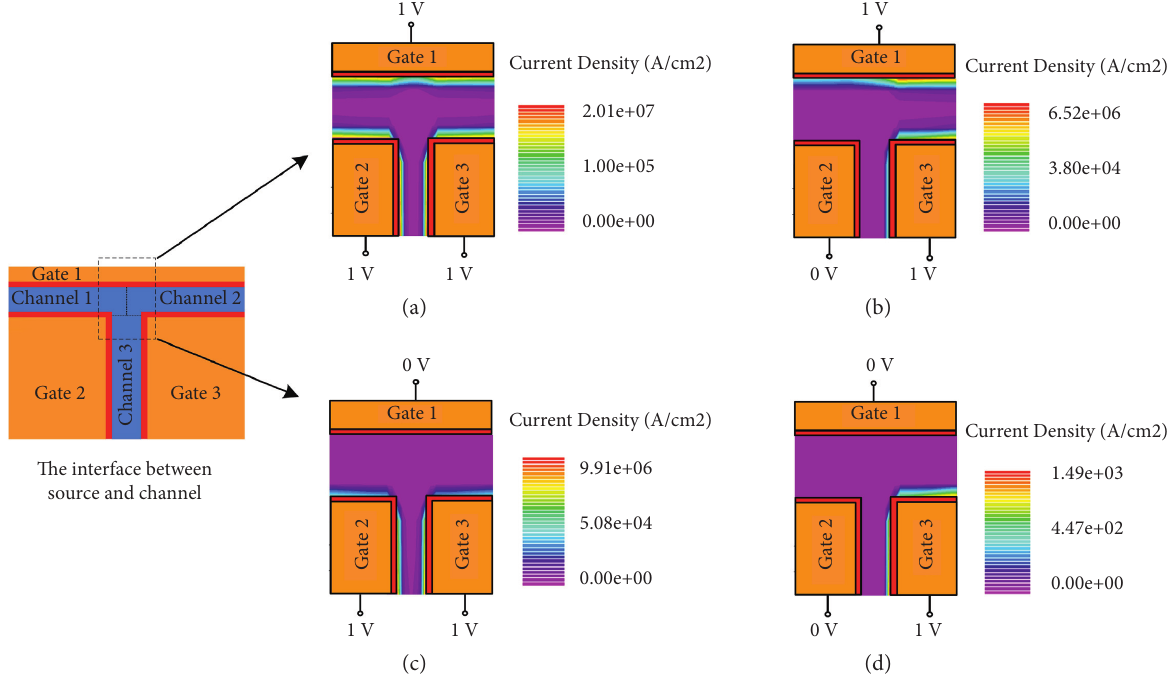
Figure 3: Contour plots of the current density on the interface between source and channel with V